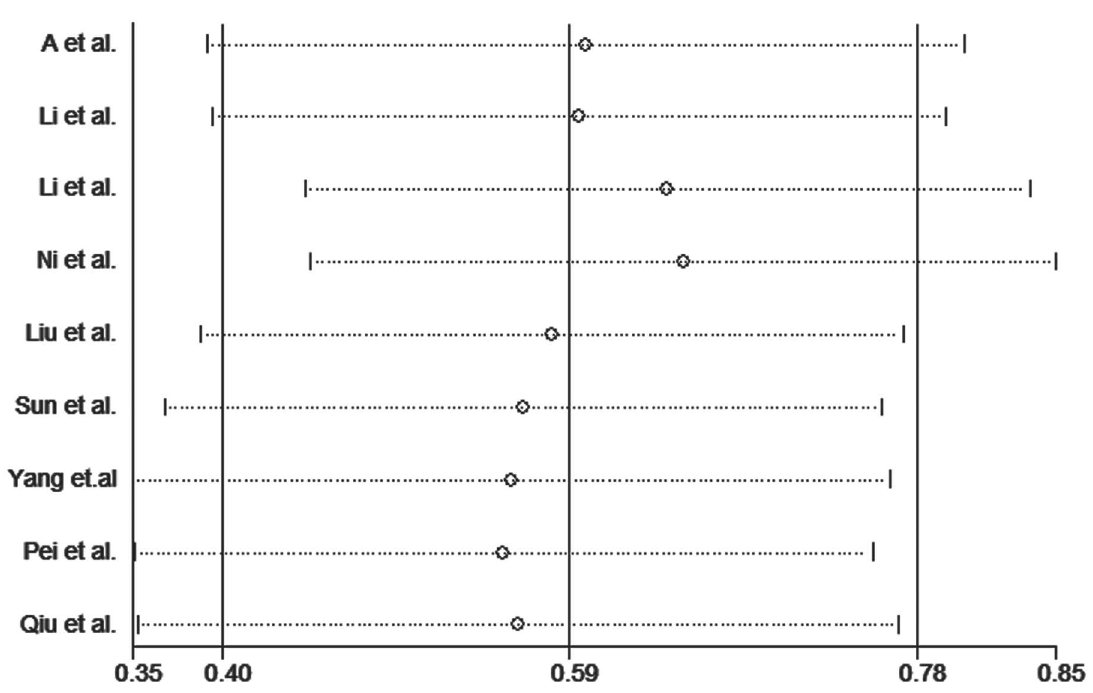
Fig 10. Sensitivity analysis diagram for each study used to assessthe relative risk estimates for the MTHFR C677T polymorphism and male infertility in all of the included studies. (recessivemodel: TT vs. TC +